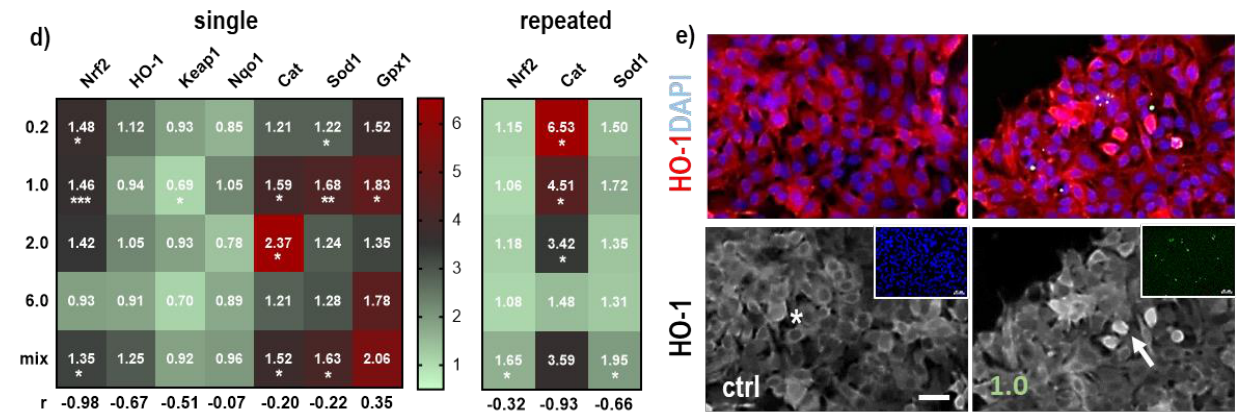
Figure 3. Activation of oxidative stress signaling in murine lung epithelial cells after NMP exposure. ( a ) Scheme of Nrf2 pathway activation and target gene expression; ( b ) representative images of cellular Nrf2 localization in untreated cells (ctrl; star, cytoplasm), and cells exposed to 1.0 µm-sized NMP (arrow, nuclear staining); ( c ) expression values of Nrf2, HMOX1, Keap1 NQO1, and GSTA1 mRNA after single (left) and repeated (right) treatment using qPCR (upper panel), expression values of CAT, SOD1, SOD2, GPx2, GSR (middle panel), and TXN2, SRXN, HSP70, HSP90A, iNOS (bottom panel) were measured using qPCR after single and repeated NMP exposure; ( d ) heatmap of Nrf2 signaling and downstream targets by protein expression quantification; ( e ) representative images of cellular HO-1 localization in untreated cells (ctrl; star, cytoplasm) and cells exposed to 1.0 µm-sized NMP (arrow, nuclear staining) with nuclei counterstained with DAPI (blue). Data were normalized to GAPDH/RLP13A and untreated controls (ctrl) and presented as mean + SE. Statistical analysis was done by unpaired, two-tailed Student ’s t-test with * p < 0.05, ** p < 0.01, and *** p < 0.001. Scale bars are 50 µm (b, e).